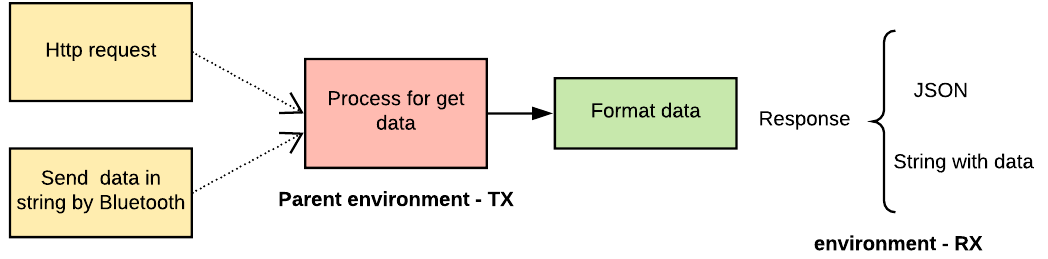
Figure 5: Interaction in the handler of Central